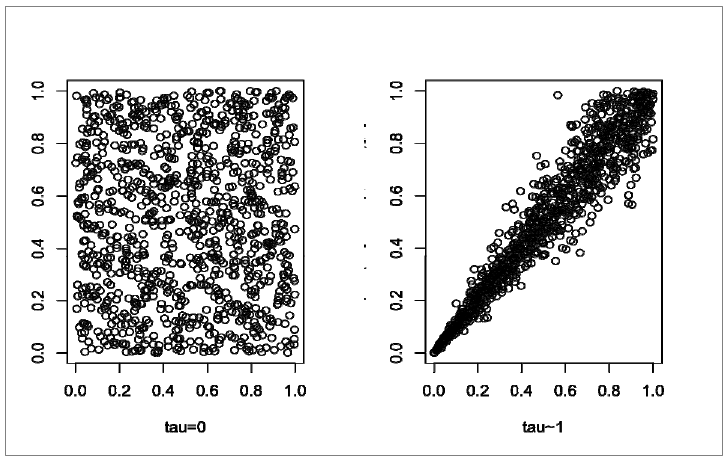
Figure 4. tau=0: simulation of independent data; tau~1: simulation of a perfectly dependent